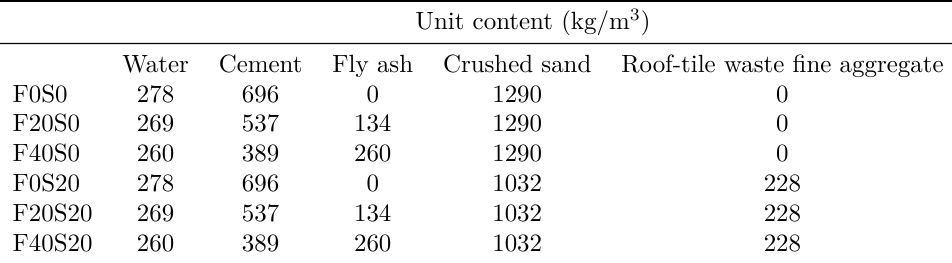
Table 3. Mixture